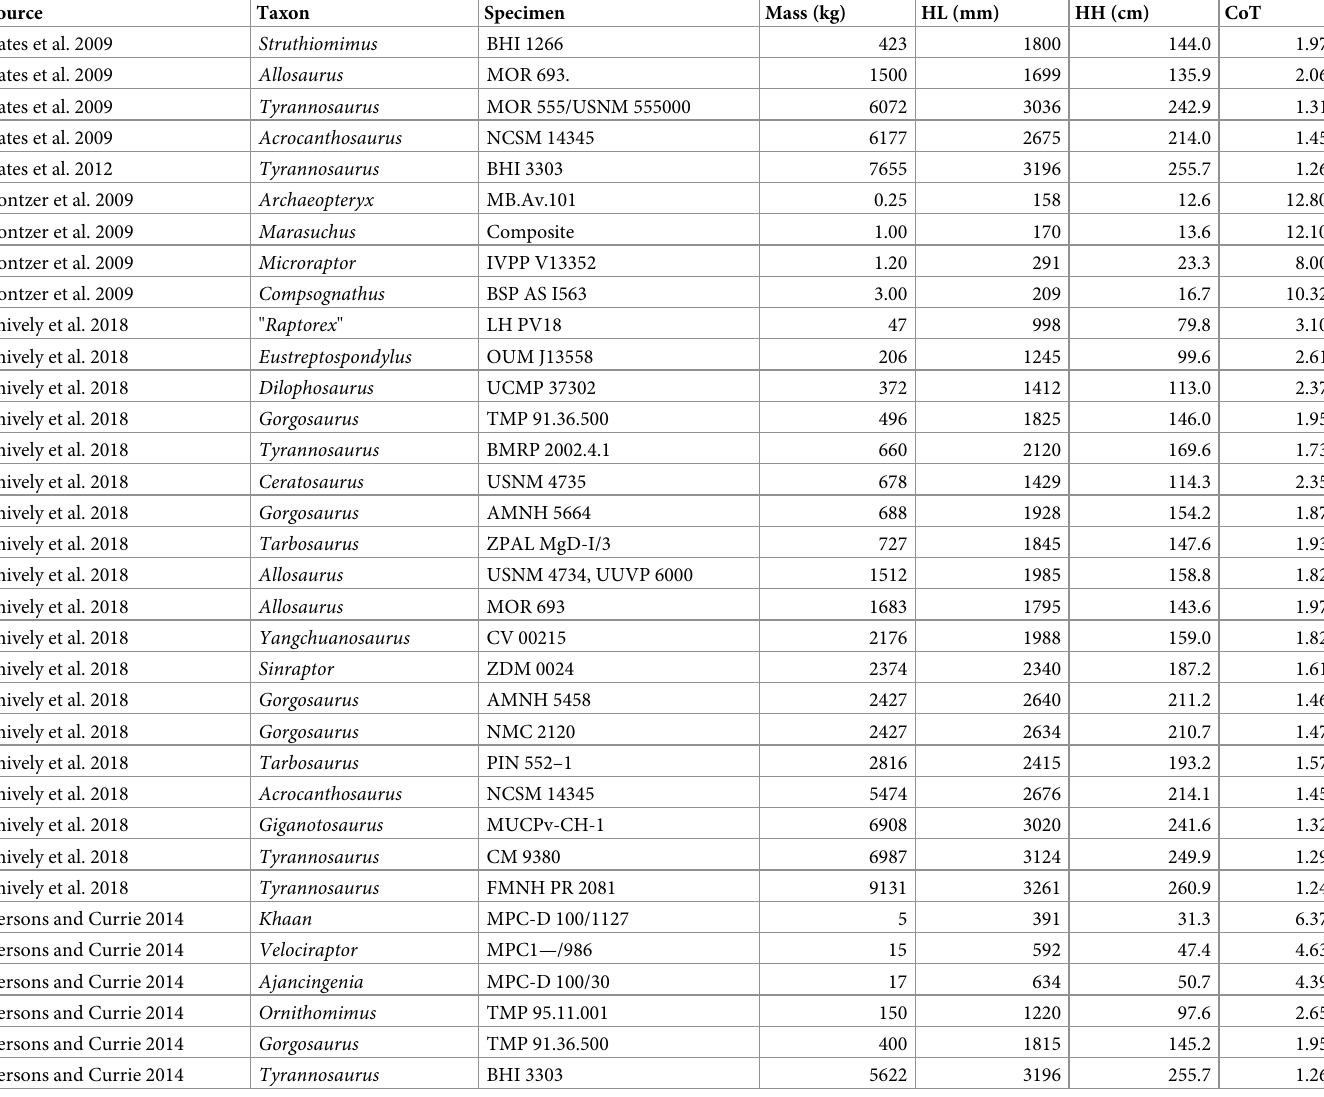
Table 1. Mass, hindlimb and hip height and cost of transport for 3D volumetric specimens examined